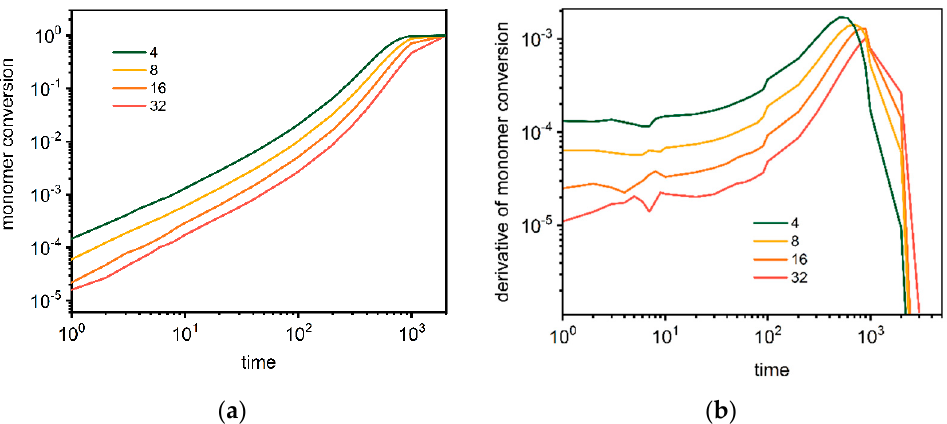
Figure 2. Conversion of a monomer ( a ) and its derivative ( b ) as a function of time during polymerization of dendrimers. The color indicates the number of macromolecules in the system (see text for details).